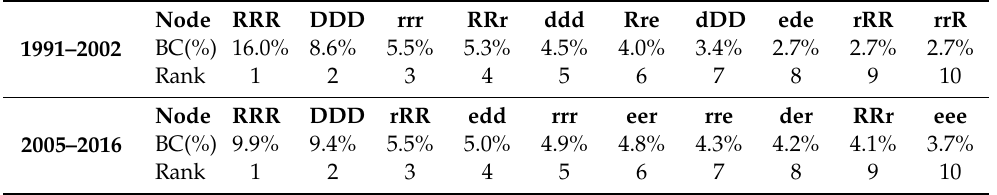
Table 3. Betweenness centrality (BC) of nodes among networks before and after